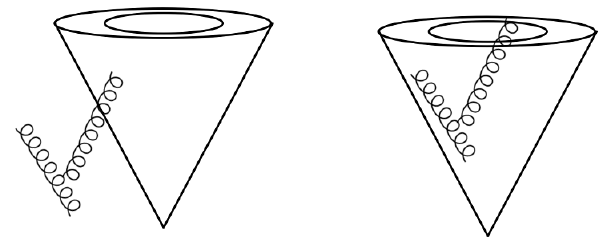
(cid:11) 2 ln 2 z cut s (cid:24)